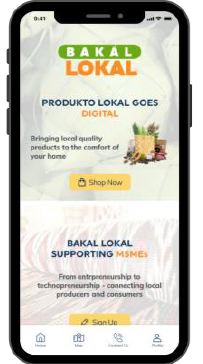
Figure 3. Local Products